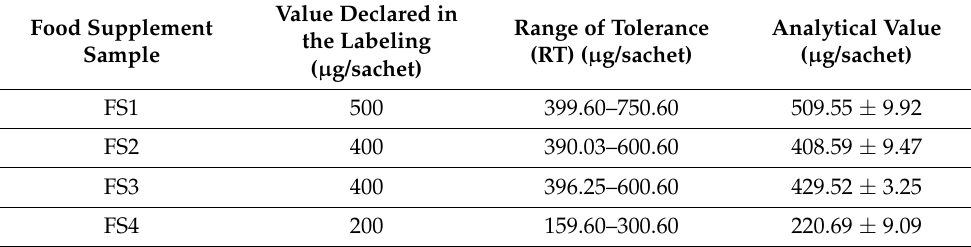
Table 4. Assessment of the tolerance established for folic acid in the food supplements samples according to the Guidance document for competent authorities for the control of compliance with EU legislation with regard to the setting of tolerances for nutrient values declared in the labeling of food